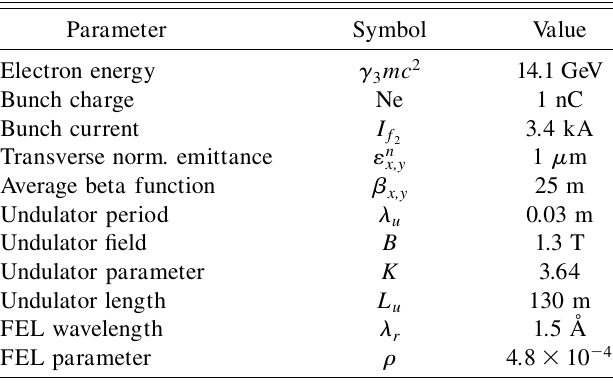
TABLE I. Main parameters for the LCLS FEL.